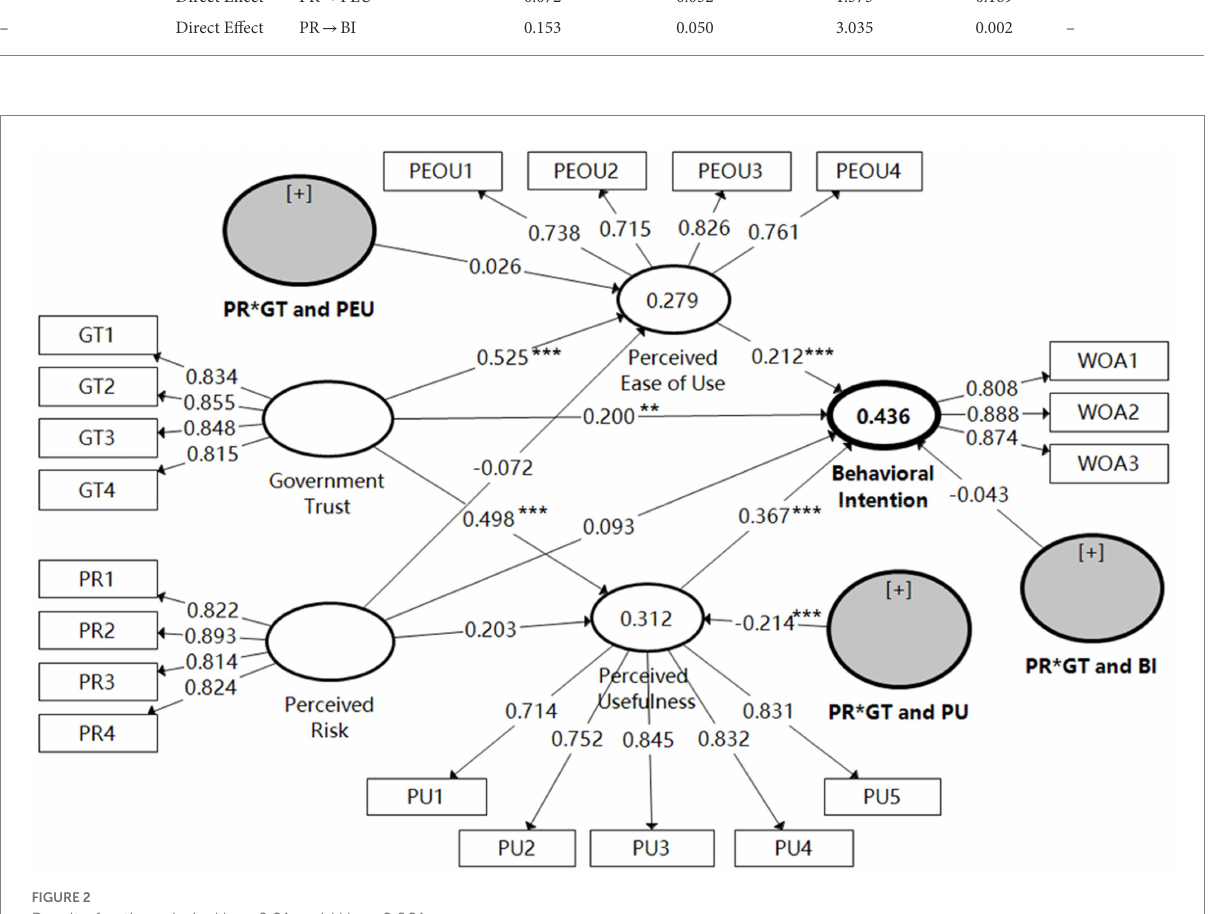
FIGURE 2 Result of path analysis. ** p < 0.01 and *** p <